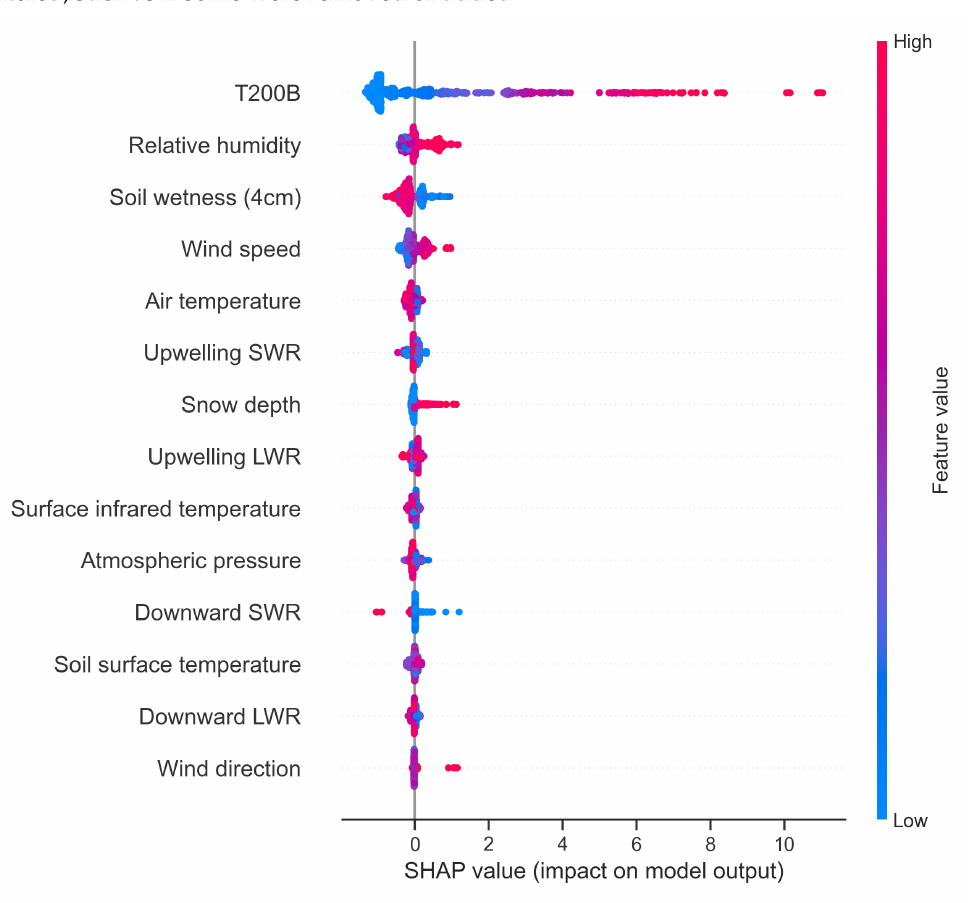
Figure 5. The SHAP values of all meteorological variables. Each line in the graph represents a feature; the horizontal coordinates are SHAP values. A dot represents a sample. The redder the color, the larger the value of the feature itself. The bluer the color, the smaller the value of the feature